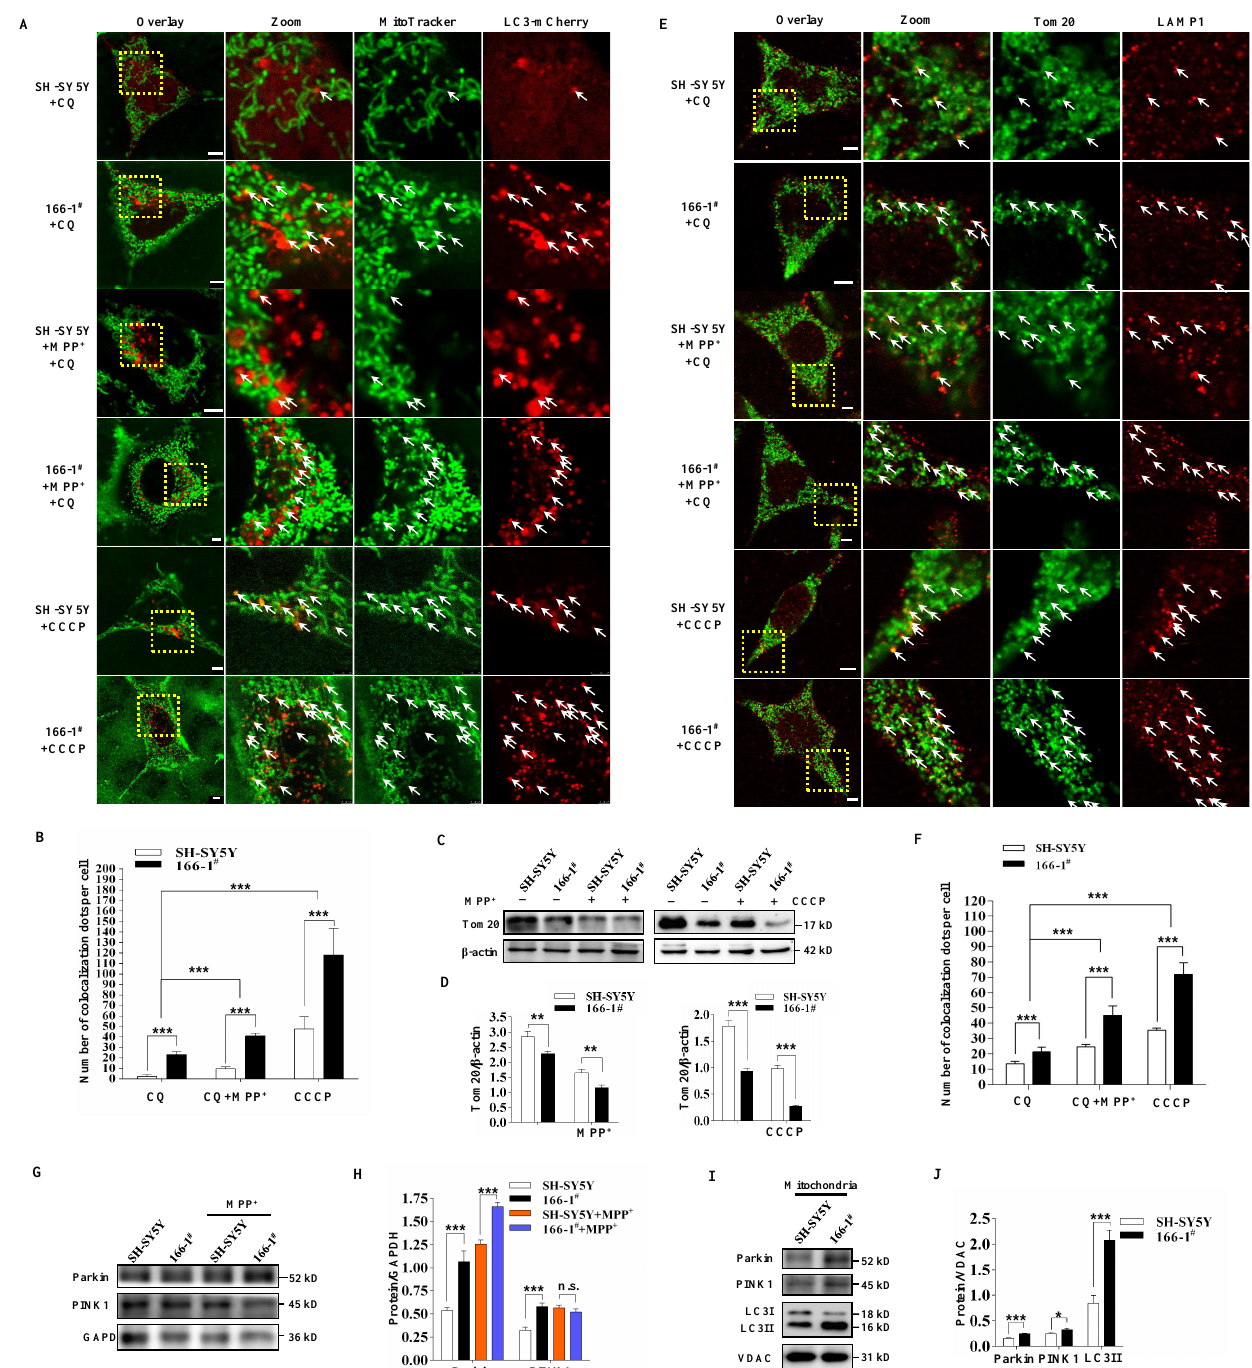
Figure 4. Overexpressed TMEM166 promotes mitophagy. ( A ) SH-SY5Y and 166-1 # cells transfected with LC3-mCherry were treated with 50 µ M CQ for 1.5 h or 1 mM MPP + for 24 h combined with CQ (50 µ M, last 1.5 h) or 10 µ M CCCP for 6 h, then were stained with MitoTracker and we performed the live cell imaging. Arrows present the colocalization dots of mitochondria and LC3. Scale bars, 5 µ m. ( B ) Statistical data of colocalization dots of LC3-mCherry with mitochondria per cell are shown as the means ± SDs from 20 cells of duplicate experiments. ( C ) SH-SY5Y and 166-1 # cells were treated with 1 mM MPP + for 24 h or 10 µ M CCCP for 6 h and the expression level of the mitochondrial